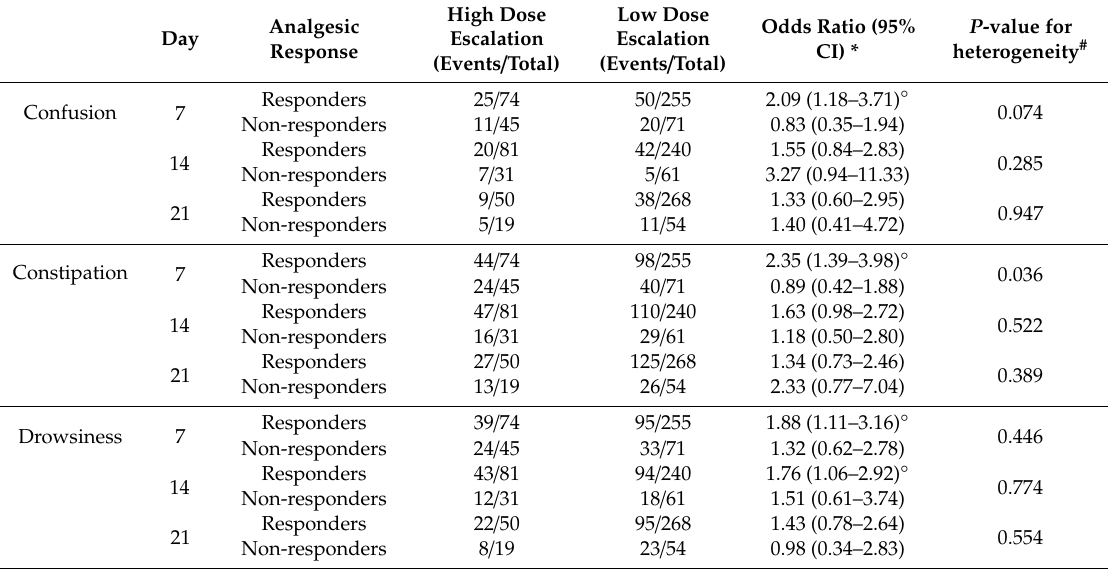
Table 5. Adverse events over time according to analgesic response and dose escalation among 498 cancer